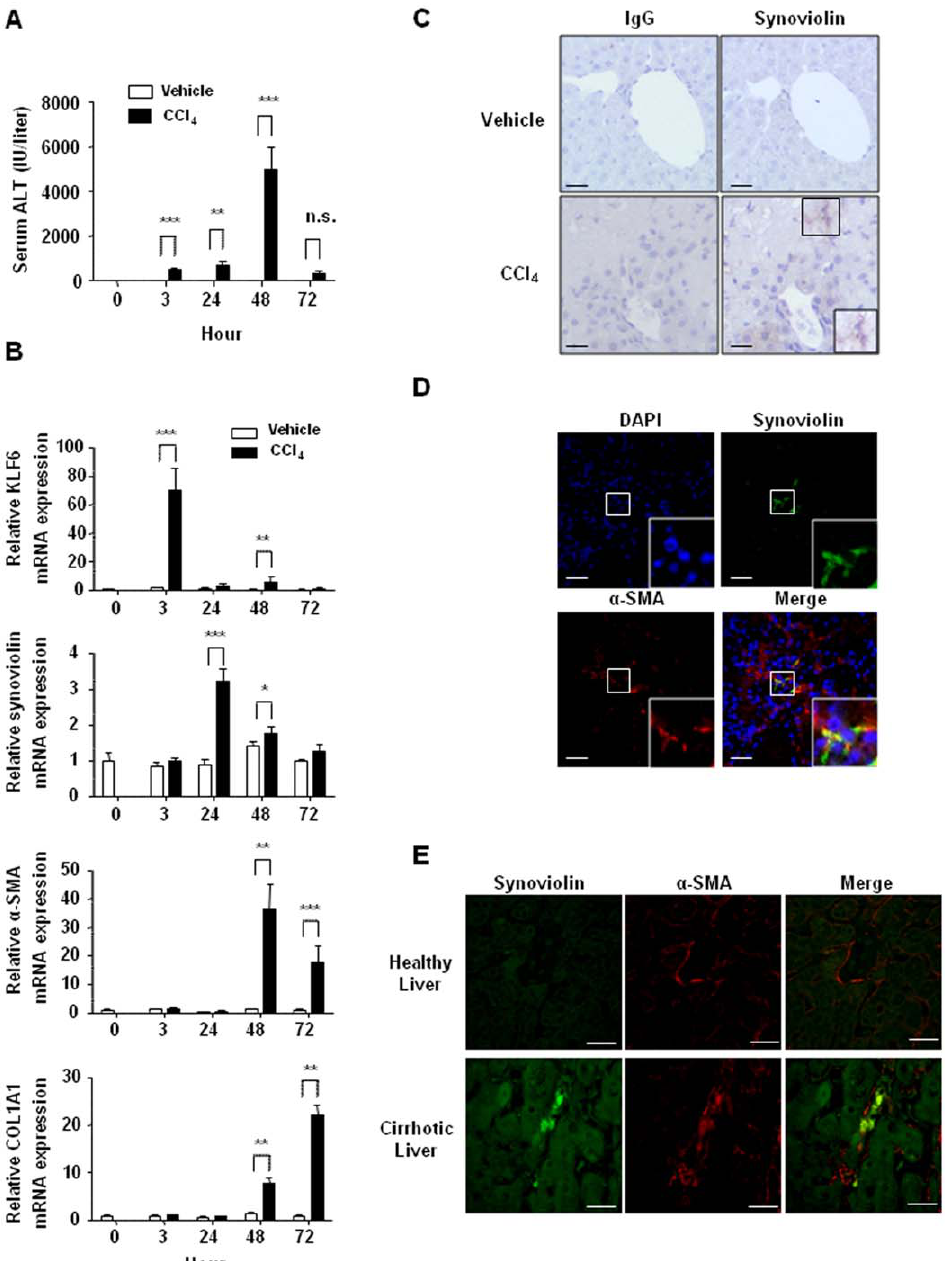
Figure 1. Invivo assessment of synoviolin expression in hepatic injury. (A) The serum levels of alanine aminotransferase (ALT) were analyzed at 0, 3, 24, 48, and 72 h after CCl 4 administration in the acute hepatic injury model mice. Data are represented as mean 6 SEM (n=4–5 mice per group). Unpaired Student’s t -test was used for statistical analysis. *** P , 0.001, ** P , 0.01. (B) Time-course expression of KLF6, synoviolin, Acta2 ( a - SMA), and COL1A1 (collagen I) mRNA in livers inoculated with CCl 4 (black bar) or vehicle (white bar) quantified using real-time RT-PCR. Data are represented as mean 6 SEM (n=4–5 mice per group). The mRNA level was normalized relative to the amount of the transcript of 18S rRNA, a housekeeping gene. Unpaired Student’s t -test was used for statistical analysis. *** P , 0.001, ** P , 0.01, * P , 0.05. (C) Immunohistochemical analysis of liver sections of wt mice at 48 h after treatment with CCl 4 (n=4) or vehicle (n=5). The expression and localization of synoviolin (arrows, right panel) were analyzed using anti-synoviolin antibodies. Normal IgG antibody was used for the negative control (left panels). Scale bar =100 m m. (D) Double- labeled fluorescent immunohistochemical analysis of liver sections of wt mice at 48 h after treatment with CCl 4 (n=4). The nuclei were counterstained with DAPI (Vectashield). The expression and localization of synoviolin (green) and a -SMA (red)—a marker of activated HSCs, were analyzed using anti-synoviolin and a -SMA antibodies. Scale bar =200 m m. (E) Double-labeled fluorescent immunohistochemical analysis of liver sections of human healthy liver (n=30) and cirrhotic liver (n=40) using human tissue array sections. The expression and localization of synoviolin (green label) a -SMA (red label) were analyzed using anti-synoviolin and a -SMA antibodies. Scale bar =100 m m.